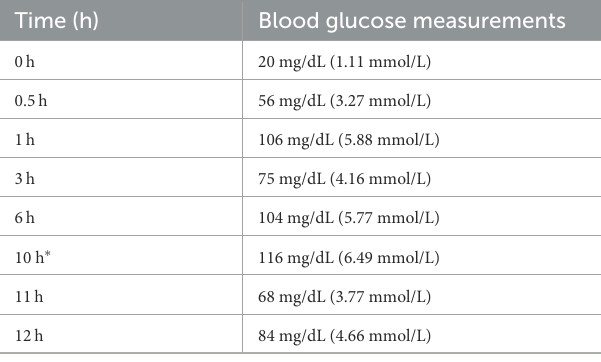
TABLE 1 Serial blood glucose measurements performed using the AlphaTRAK blood glucose monitoring system (see text footnote